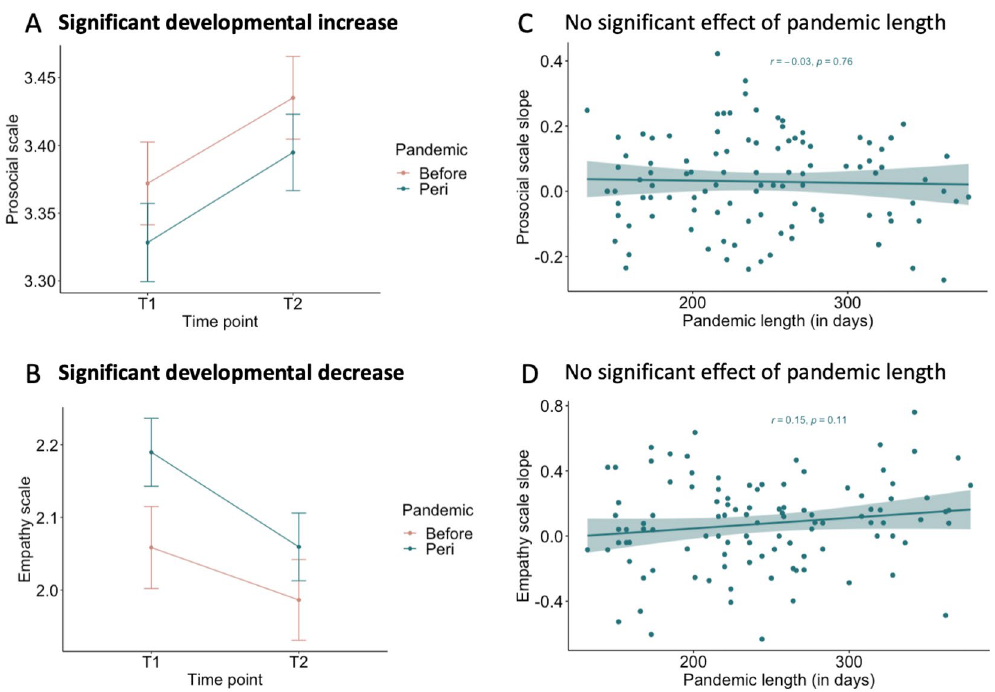
Figure 6. Visualizations of the linear mixed model results of prosocial and empathic development. In ( A ) prosocial behavior scale is presented on the y-axis and time point on the x-axis, showing a significant developmental increase independent of pandemic group. In ( B ) empathic behavior scale is presented on the y-axis and time point on the x-axis, showing a significant developmental decrease independent of pandemic group. In ( C ) slopes of prosocial behavior of participants in the peri -pandemic group are presented on the y-axis and pandemic length (in days) on the x-axis, showing no association. In ( D ) slopes of empathic behavior of participants in the peri -pandemic group are presented on the y-axis and pandemic length (in days) on the x-axis, showing no